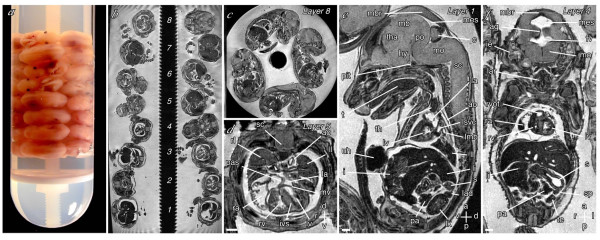
High-throughput high-resolution magnetic resonance microscopy. (a) Stack of 32 embryos embedded in a NMR tube. (b) Section through the long axis of the NMR tube showing embryos in eight layers. (c) Sagittal section through layer 8 showing the four embryos in this layer. (d–f) Transverse, sagittal, and coronal sections through individual embryos in layers 5, 1 and 4 respectively. The voxel size is 25.4 × 25.4 × 24.4 μm. Structures indicated are the spinal cord (sc), the right and left lungs, atria and ventricles (rl, ll, ra, la, rv, lv), primary atrial and interventricular septa (pas, ivs), mitral valve (mv), midbrain roof (mbr), midbrain (mb), mesencephalic vesicle (mes), thalamus (tha), hypothalamus (hy), pons (po), cerebellum (c), medulla oblongata (mo), pituitary (pit), tongue (t), thymus (th), left superior vena cava and main bronchus (lsvc, lmb), aorta (ao), liver (li), stomach (s), left adrenal and kidney (lad, lk), pancreas (pa), intestines (i), umbilical hernia (uh), aqueduct of Sylvius (aq), fourth ventricle (fv), inner ear (ie), larynx (lar), right ventricular outflow tract (rvot), spleen (sp), and testes (te). Scale bars = 500 μm; axes: d – dorsal; v – ventral; r – right; l – left; a – anterior, p – posterior.